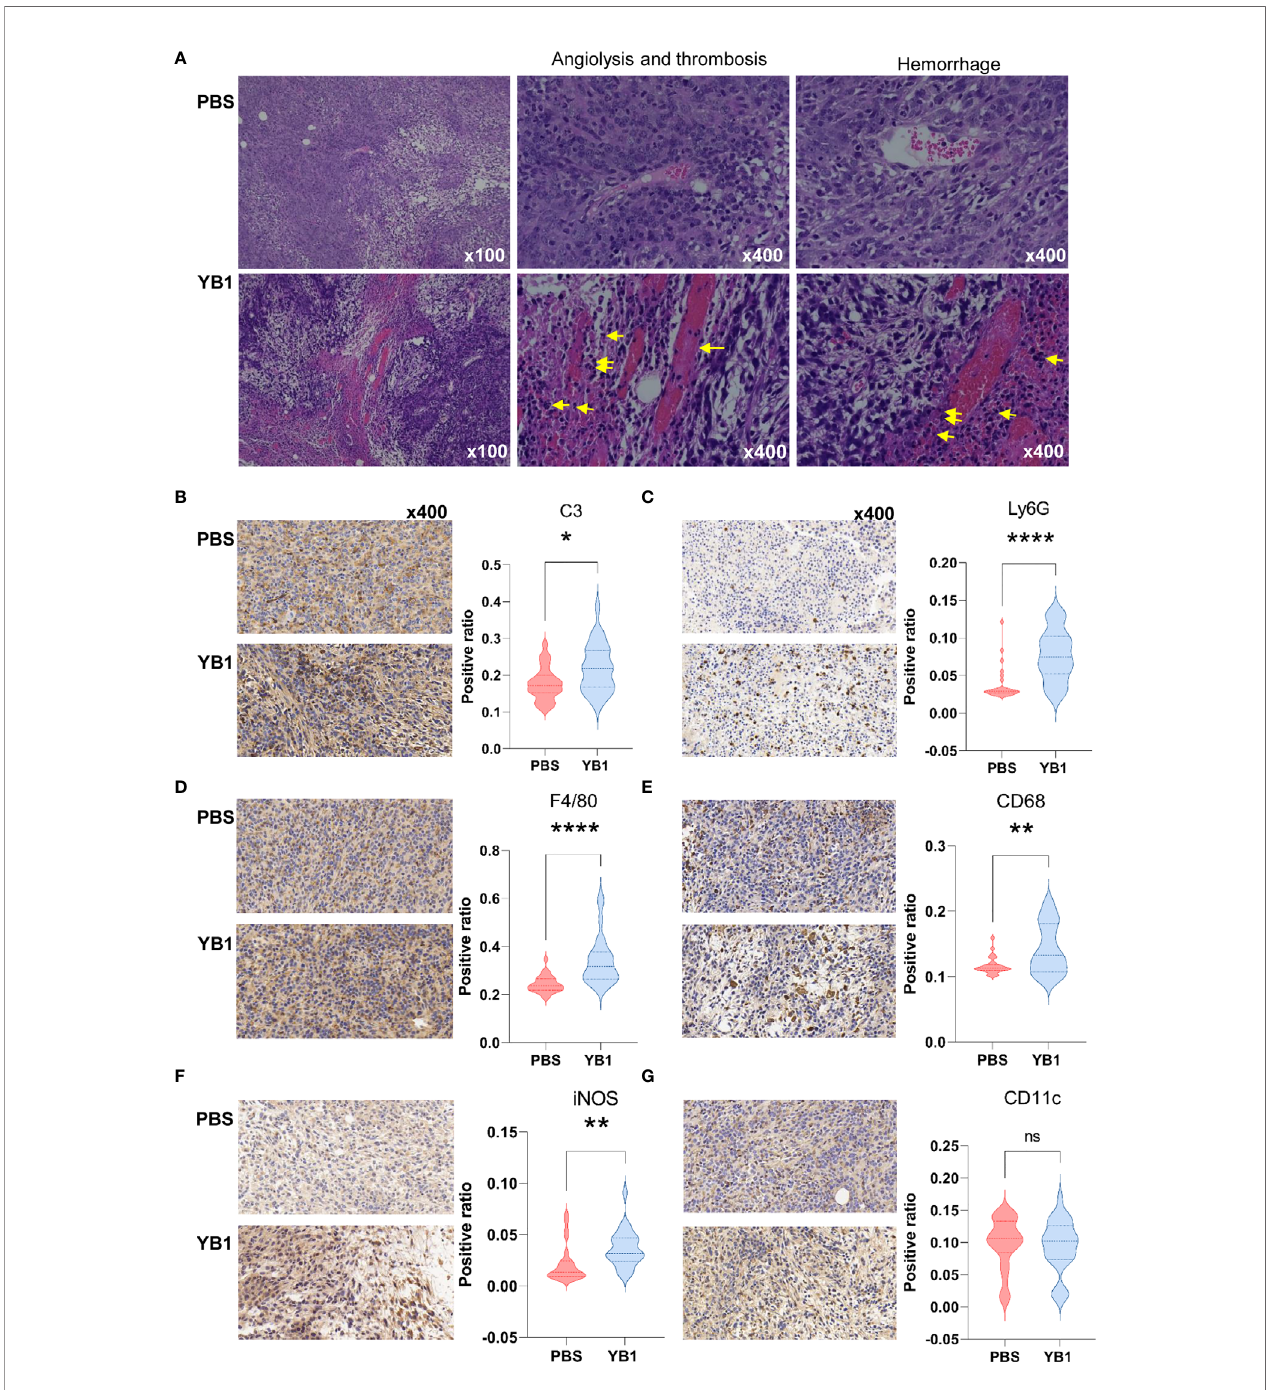
FIGURE 4 | Salmonella YB1 induced the innate immune responses in tumors. (A) Representative images of hematoxylin and eosin (H&E) – stained tumor slices collected from mice injected with phosphate-buffered saline (PBS) or YB1 at 2 days post injection. The yellow arrow indicates angiolysis, thrombosis and neutrophils in fi ltration. Area ratio (see methods) of (B) C3 + cells, (C) Ly6G + cells, (D) F4/80+ cells, (E) CD68 + cells, (F) iNOS + cells, (G) CD11c + cells based on immunohistochemical-stained images. Three biological replicates of images with nine random views under 40x magni fi cation per image were collected for statistical analysis which was performed using the K – S test.* p < 0.05, ** p < 0.01, **** p < 0.0001, ns, no signi fi cant